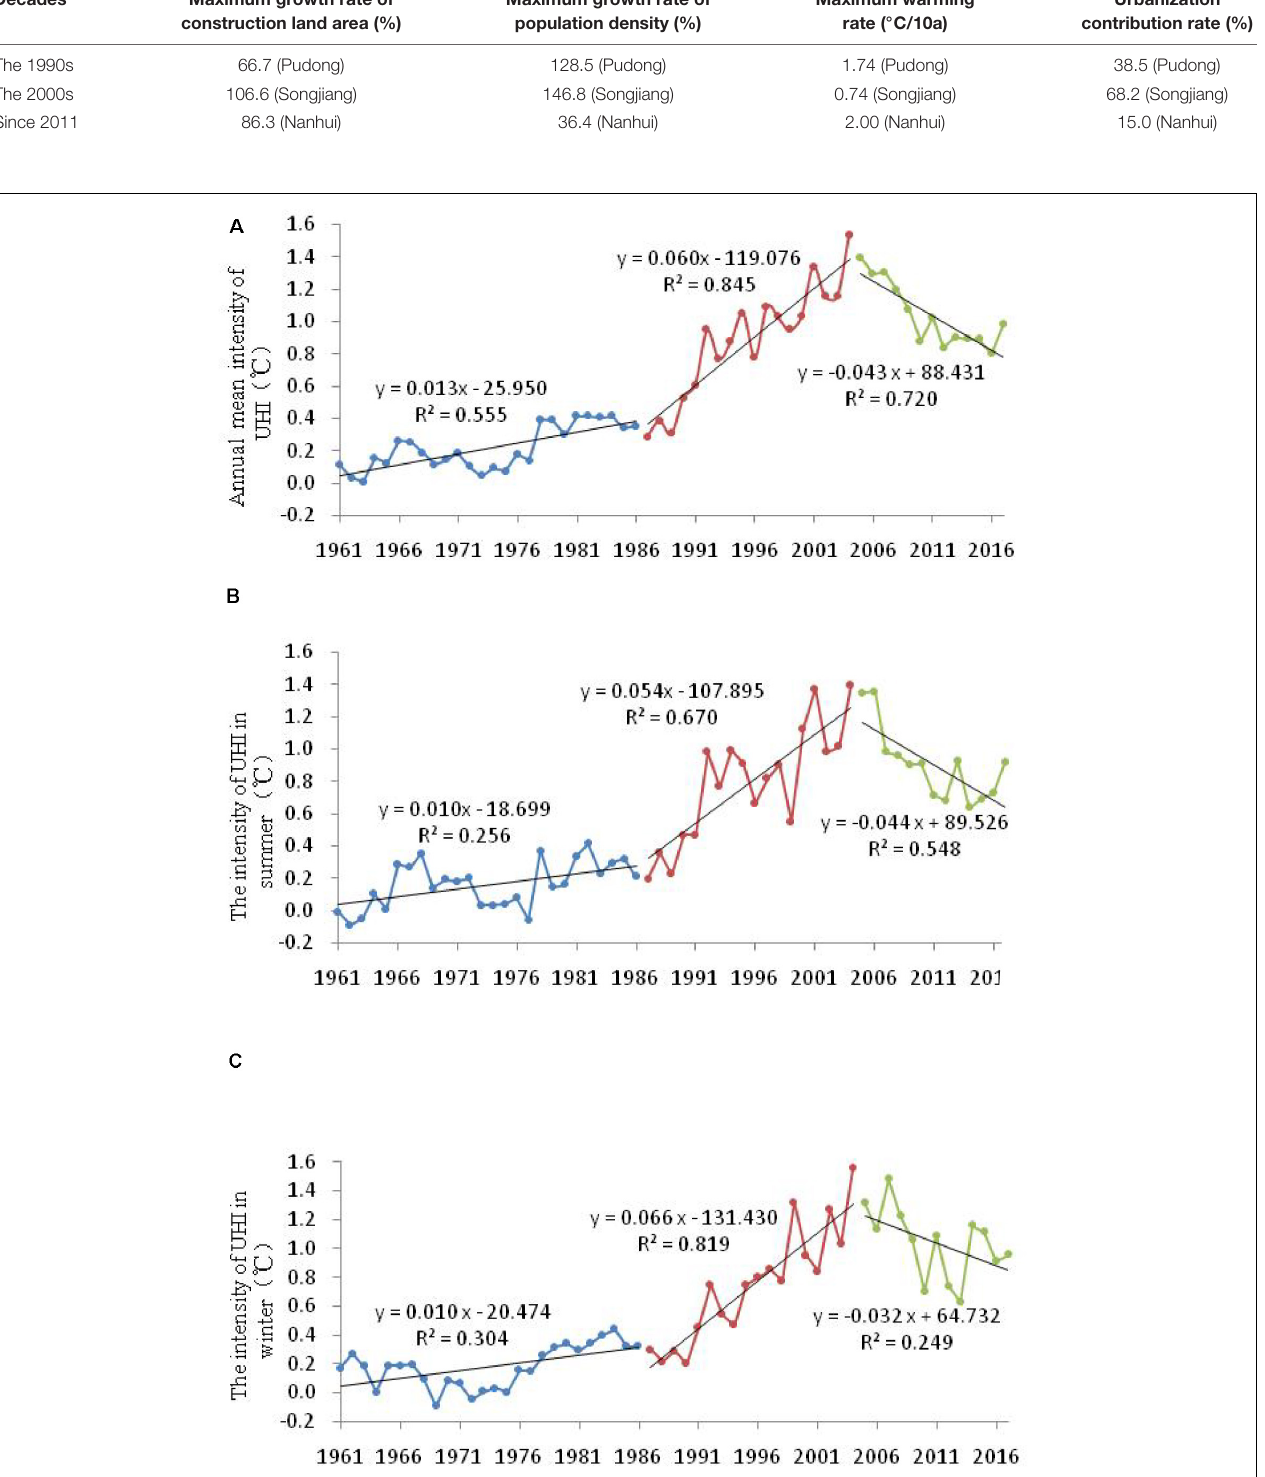
Frontiers in Earth Science |